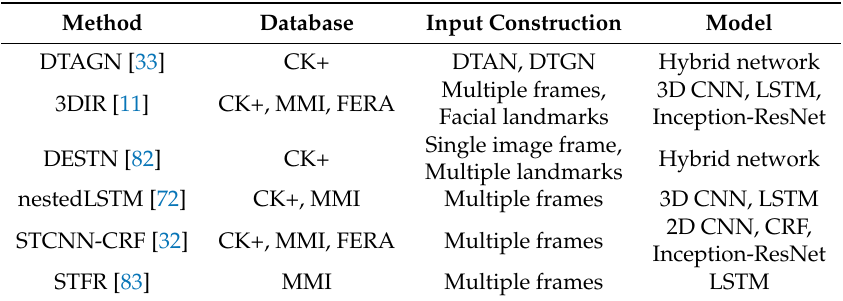
Table 5. Analysis of the state-of-the-art methods.